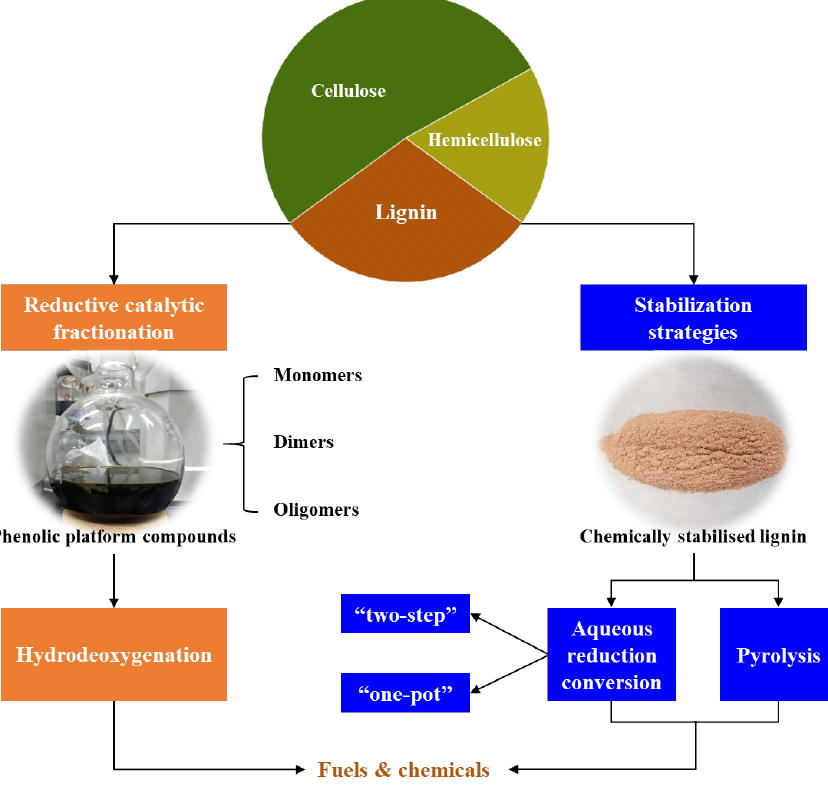
Figure 4. The subsequent conversion pathways of different lignin degradation products derived from lignin-first biorefinery.